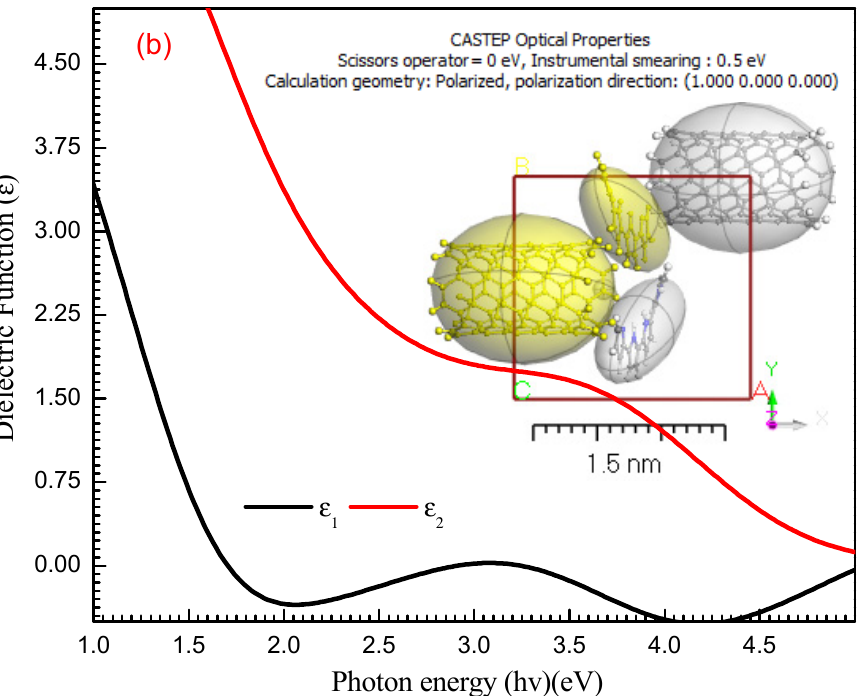
Figure 8. ( a ) the relation between ( ε 1 and ε 2 ) vs. (h ν ) eV for PPy and different types of PPy/MWCNTs composites ( b ) Simulation dielectric function for PPy/MWCNTs by employing CASTEP technique. Using the CASTEP technique, the maximum value of ε 1 ( λ ) and ε 2 ( λ ) for PPy/MWCNTs ∼ = ∼ = composites in isolate state is 7.50 eV at photon energy (eV) 3.00 and 1.50, respectively as shown in Figure 8b. For average values ε 1 ( λ ) and ε 2 ( λ ), resulted from the experimental and simulation dimensions are found within the photon energy range values of 1–53